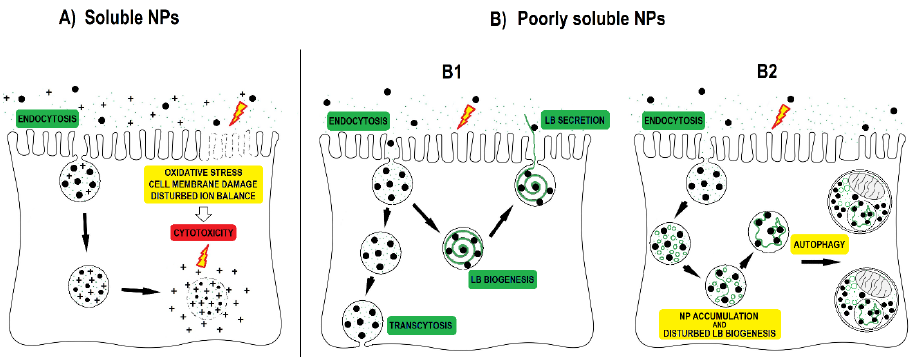
Figure 6. Nanoparticle (NP) interactions with alveolar type II cells. ( A ) Soluble NPs such as Cu, CuO and ZnO can release ions in the cell medium and even more in acid endo-lysosomal organelles after endocytosis due to the low pH. NPs and released ions in the cell medium as well as inside the cell can cause oxidative stress, damage cell membranes, and disturb the cellular ion balance, all of which can lead to cytotoxicity; ( B ) poorly soluble NPs are endocytosed by alveolar type II cells. Poorly soluble NPs can also induce oxidative stress and cytotoxicity, but usually require higher concentrations than more soluble NPs; ( B1 ) internalized NPs can be secreted out of the cell together with lung surfactant packed in lamellar bodies or can be translocated across the cell by transcytosis; ( B2 ) internalized NPs that enter the endo-lysosomal system can interfere with the synthesis and degradation of phospholipids, and with lamellar body biogenesis. NP interference with lamellar body biogenesis leads to autophagic degradation of defective lamellar bodies filled with NPs and to the accumulation of surfactant phospholipids in autophagic vacuoles (based on research of Kononenko et al., 2017 We organized the 15 tested NPs into four distinct groups according to their mode of action: (1) NPs that are highly cytotoxic and not biopersistent i.e., do not increase the load of endo-lysosomal